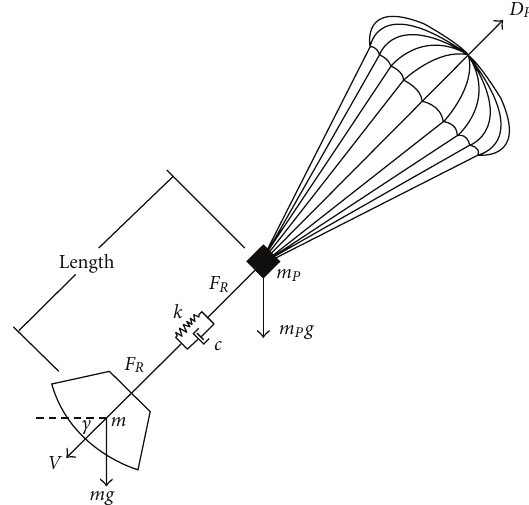
Figure 2: Layout of the suspension system (parachute-payload